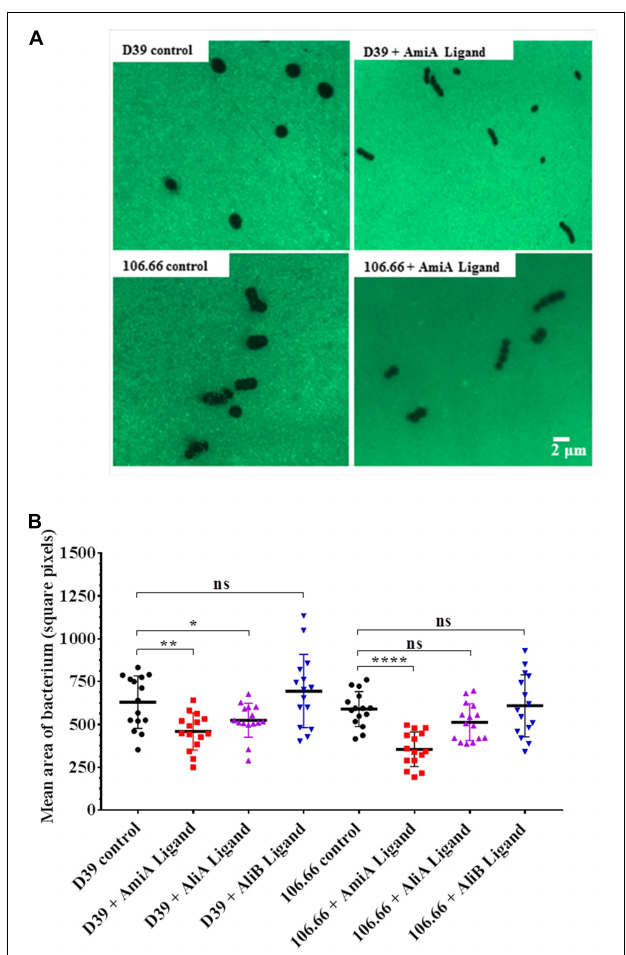
FIGURE 3 | FITC-dextran exclusion assay to determine the effect of the peptides on capsule thickness. In CDM, bacteria were grown in the presence or absence of AmiA, AliA or AliB peptide ligands to OD 600nm = 0.2. (A) A representative fluorescent image shows a visible reduction in capsule size following incubation with AmiA peptide ligand for both strains D39 and 106.66. (B) Quantification of results with all peptides presented as mean ± SD of mean area per bacterium in square pixels. Each symbol represents one image containing between 8 and 150 bacteria. ∗ p = 0.0332; ∗∗ p = 0.002; ∗∗∗∗ p = 0.0001; ns, not significant.